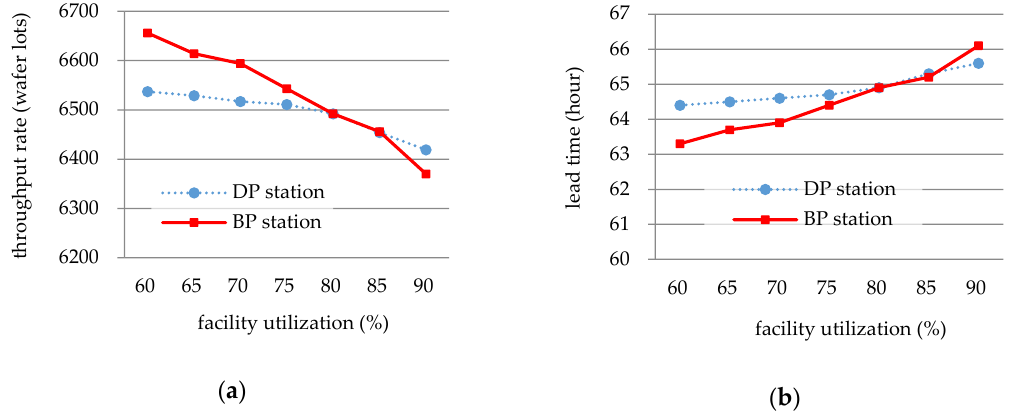
Figure 7. Performance compared over different BP and DP utilization levels in terms of ( a ) throughput rate per nine months and ( b ) system lead time.